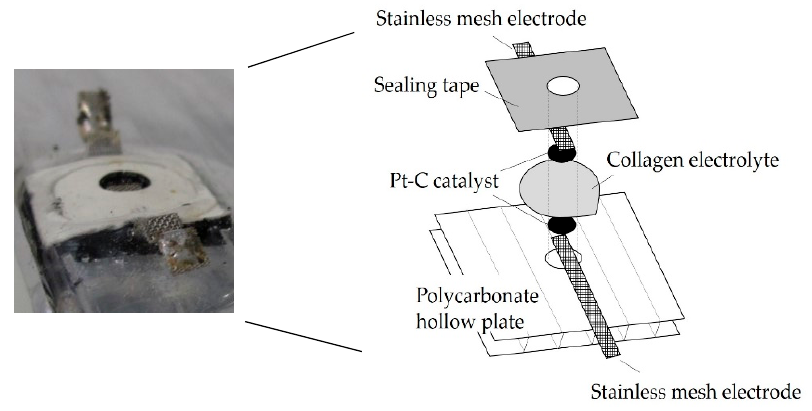
Figure 5. Collagen electrolyte fuel cell.